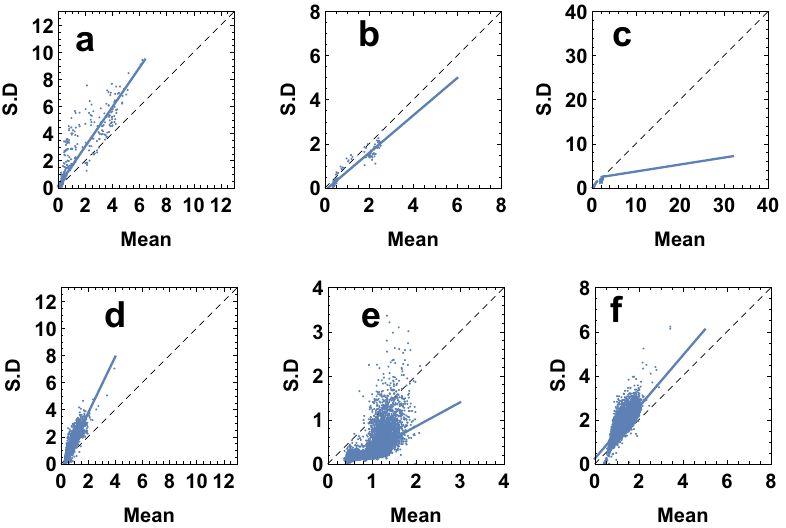
Figure 1. Observations of phytoplankton data in Tokyo Bay. Figures ( a , b , c ) show mean and standard deviation of fluorescence microstructure obtained from different locations in Tokyo Bay in May 2011. Figures ( d , e , f ) show data obtained from same location in Tokyo Bay but at different months (collected from 46